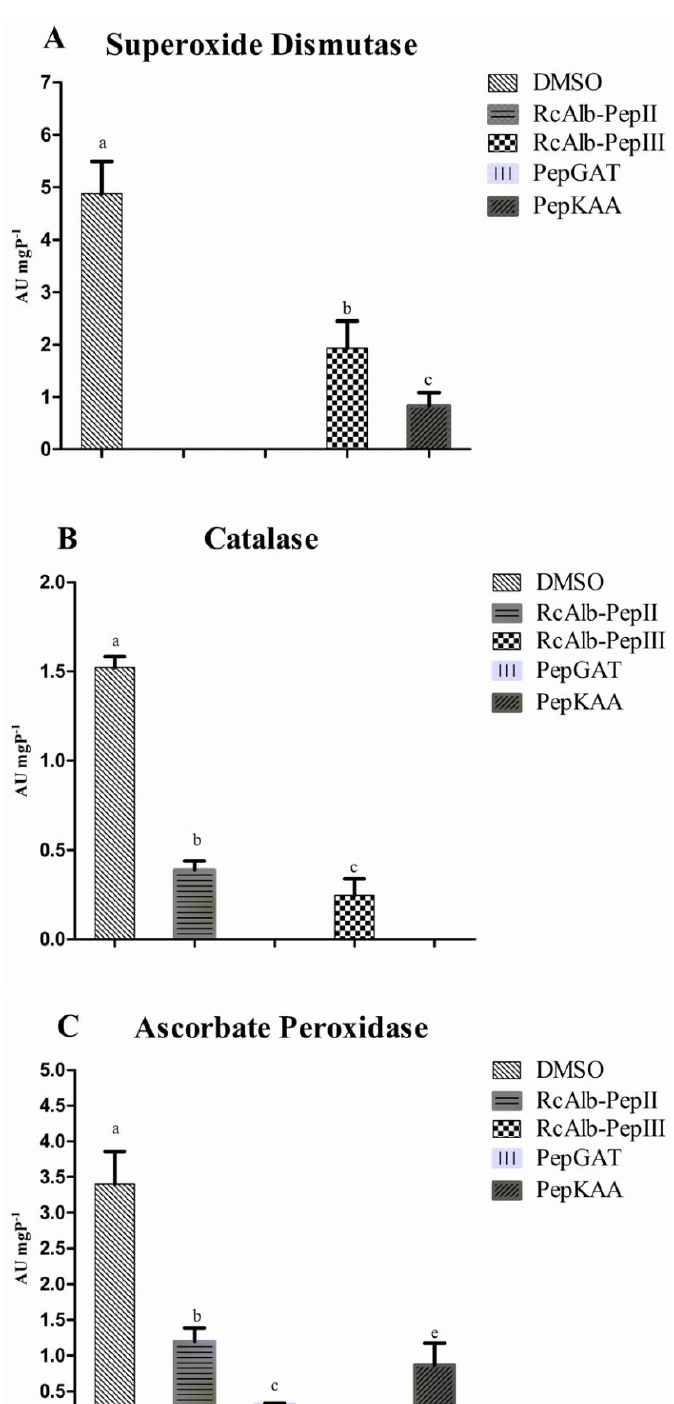
Figure 3. The activity of redox enzymes in C. neoformans cells. ( A ) SOD, ( B ) CAT, and ( C ) APX. All activities the enzymes were tested in C. neoformans cells treated and non-treated with synthetic peptides. SOD is an that enzyme that convert anion superoxide into hydrogen peroxide that is consumed by CAT and APX. The different lowercase letters indicate statistical significance at p > 0.05.